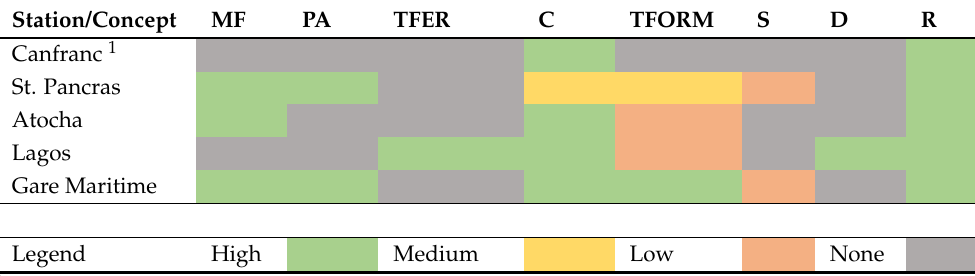
Table 4. Plot configuration analysis. Degree of transformation. Own